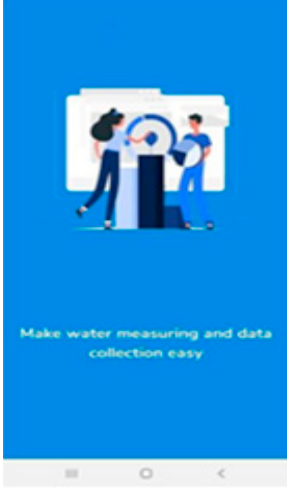
Figure 12. The welcome interface.